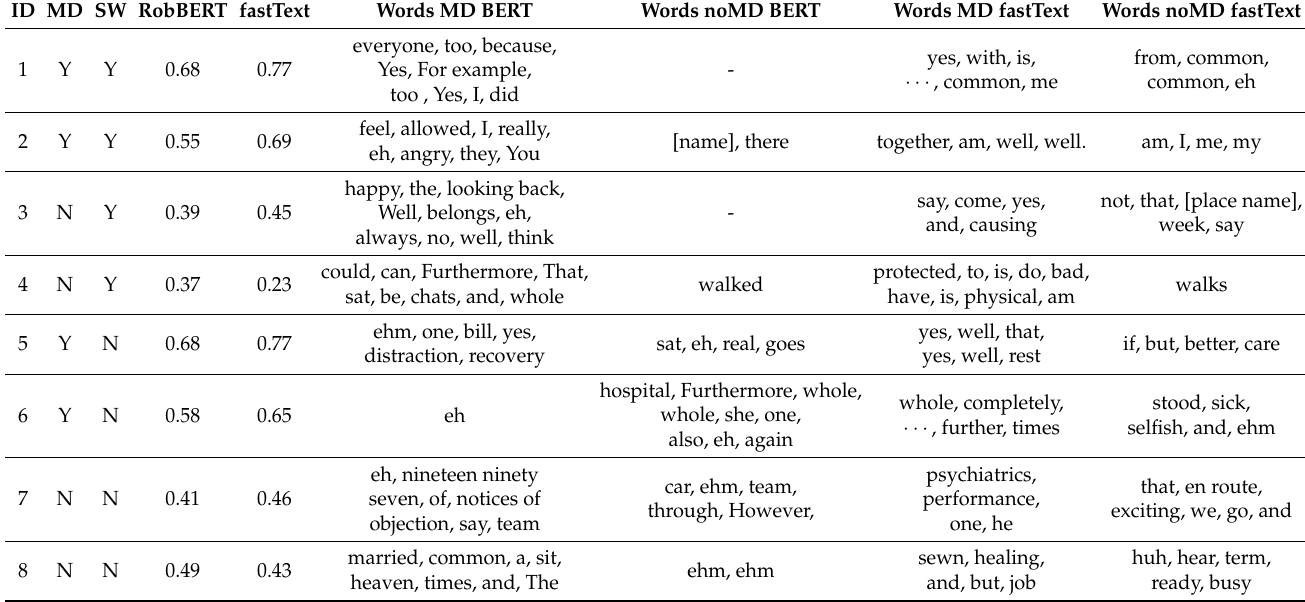
Table 5. LIME output of fastText and RobBERT for a sample of eight